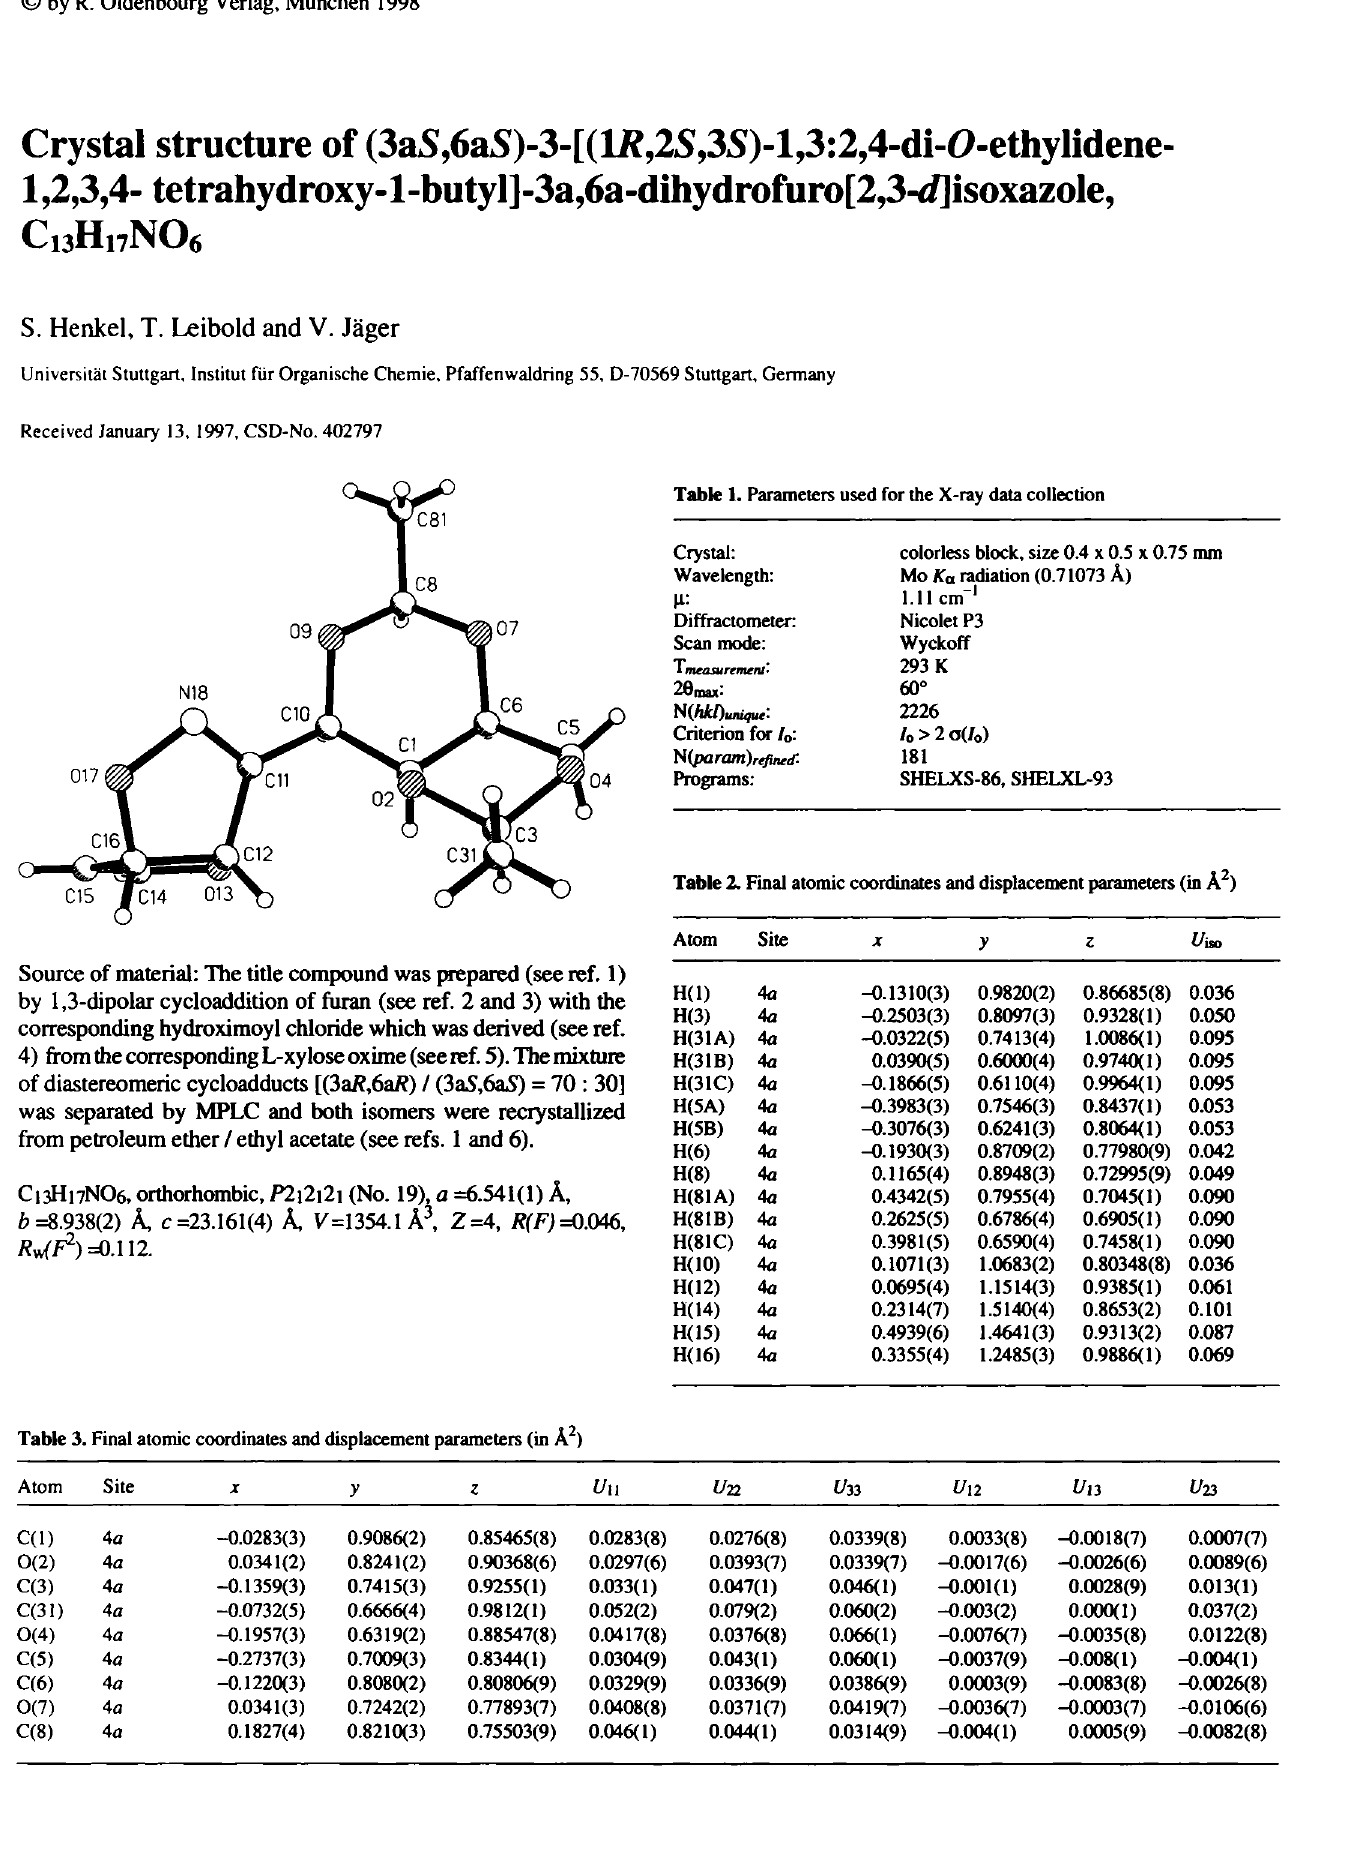
Table 3. Final atomic coordinates and displacement parameters (in Â^) Atom